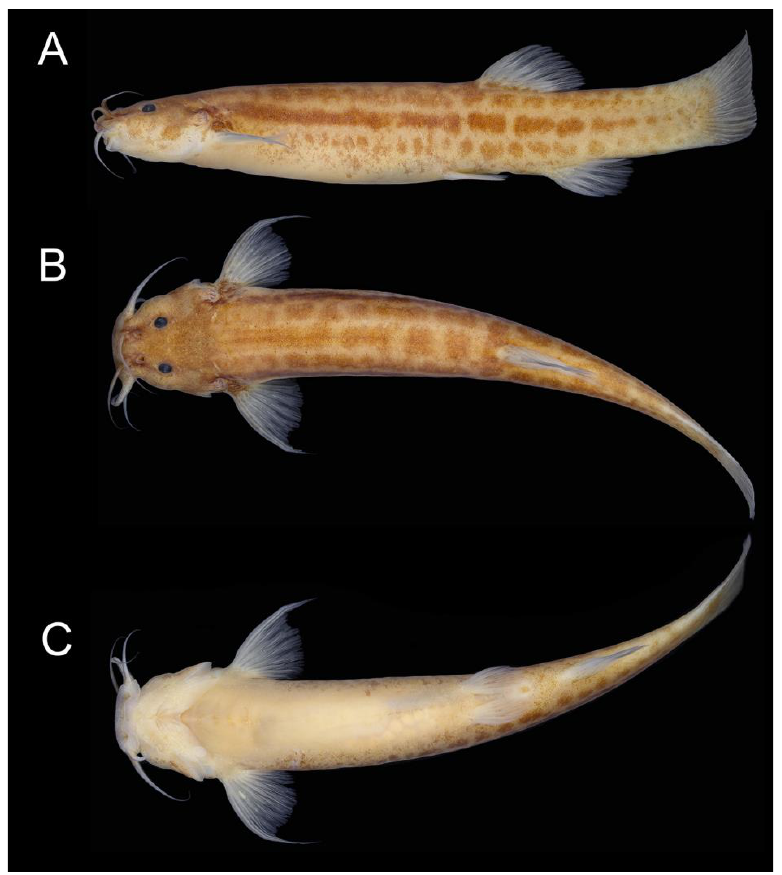
Figure 7. Trichomycterus alternatus , UFRJ 9900, 58.2 mm SL: ( A ) lateral, ( B ) dorsal, and ( C ) ventral views.